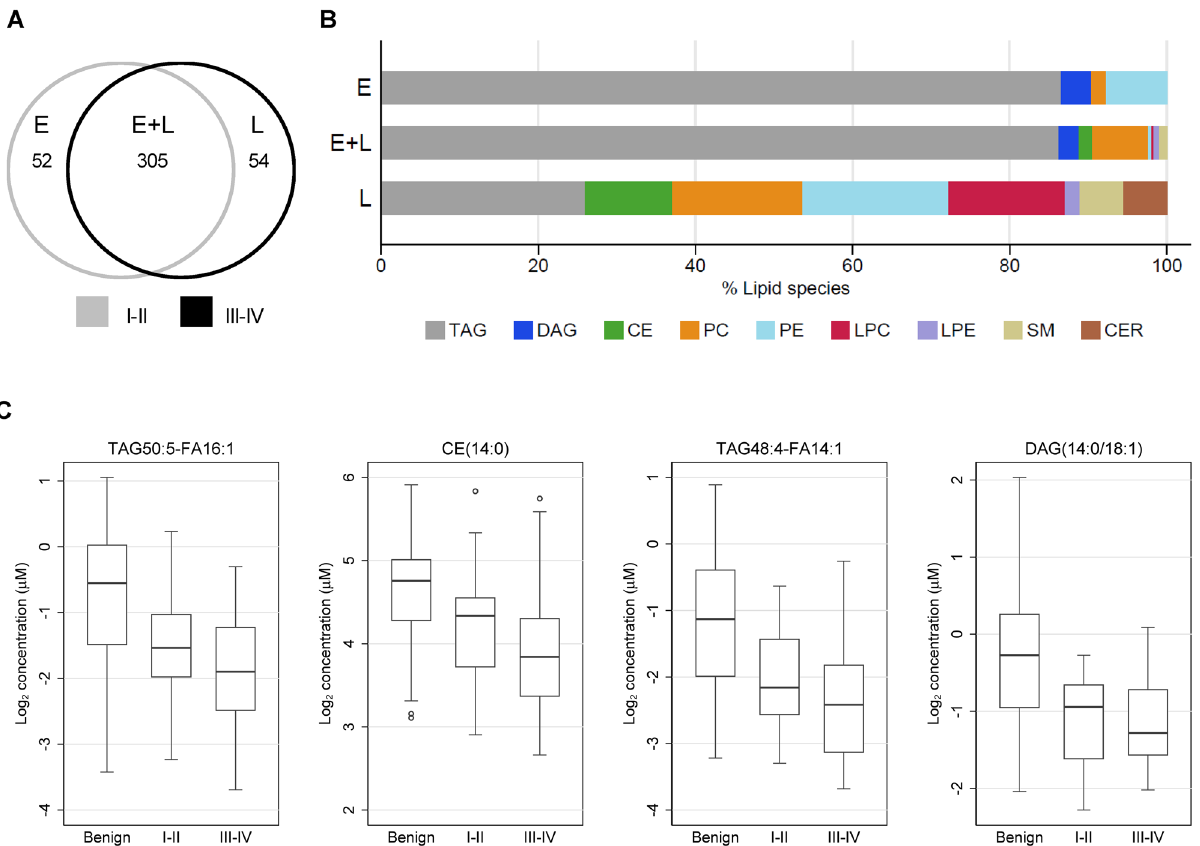
2 metabolite concentrations in the RP cohort were regressed on case status with adjustment for age and BMI. ( A ) 411 lipid species exhibited significant (FDR q < 0.05) differences in either early-stage or late-stage cases versus controls, including species significant in only the early-stage subgroup (E: n = 52), only the late- stage subgroup (L: n = 54), or both subgroups (E + L: n = 305). ( B ) Distributions of class assignments for lipid species in each category (E, E + L, L). ( C ) Box plots of plasma concentrations for top trending lipid metabolites (P trend < 9 × 10 −7